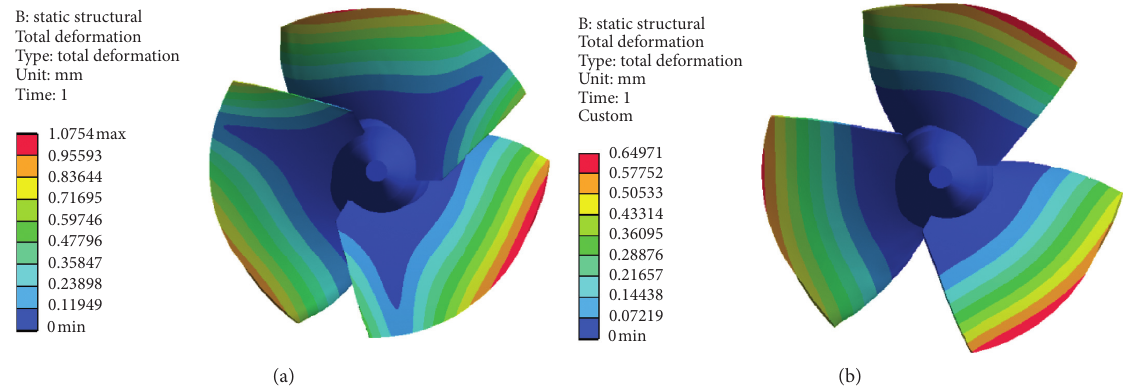
Figure 17: Distribution of blade deformation before and after optimization: (a) before optimization; (b) optimized.